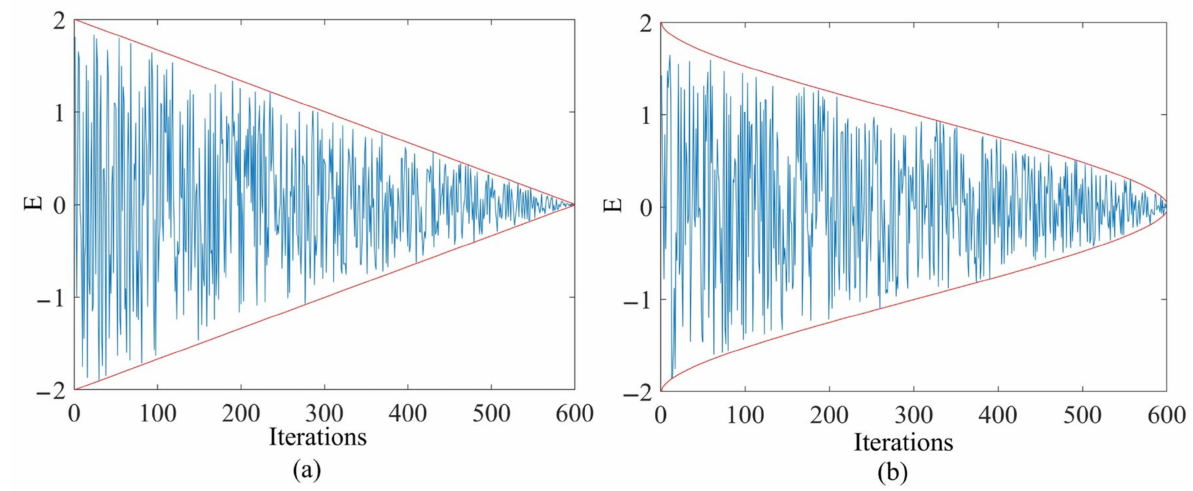
Figure 5. ( a ) The original E. ( b ) The improved E .